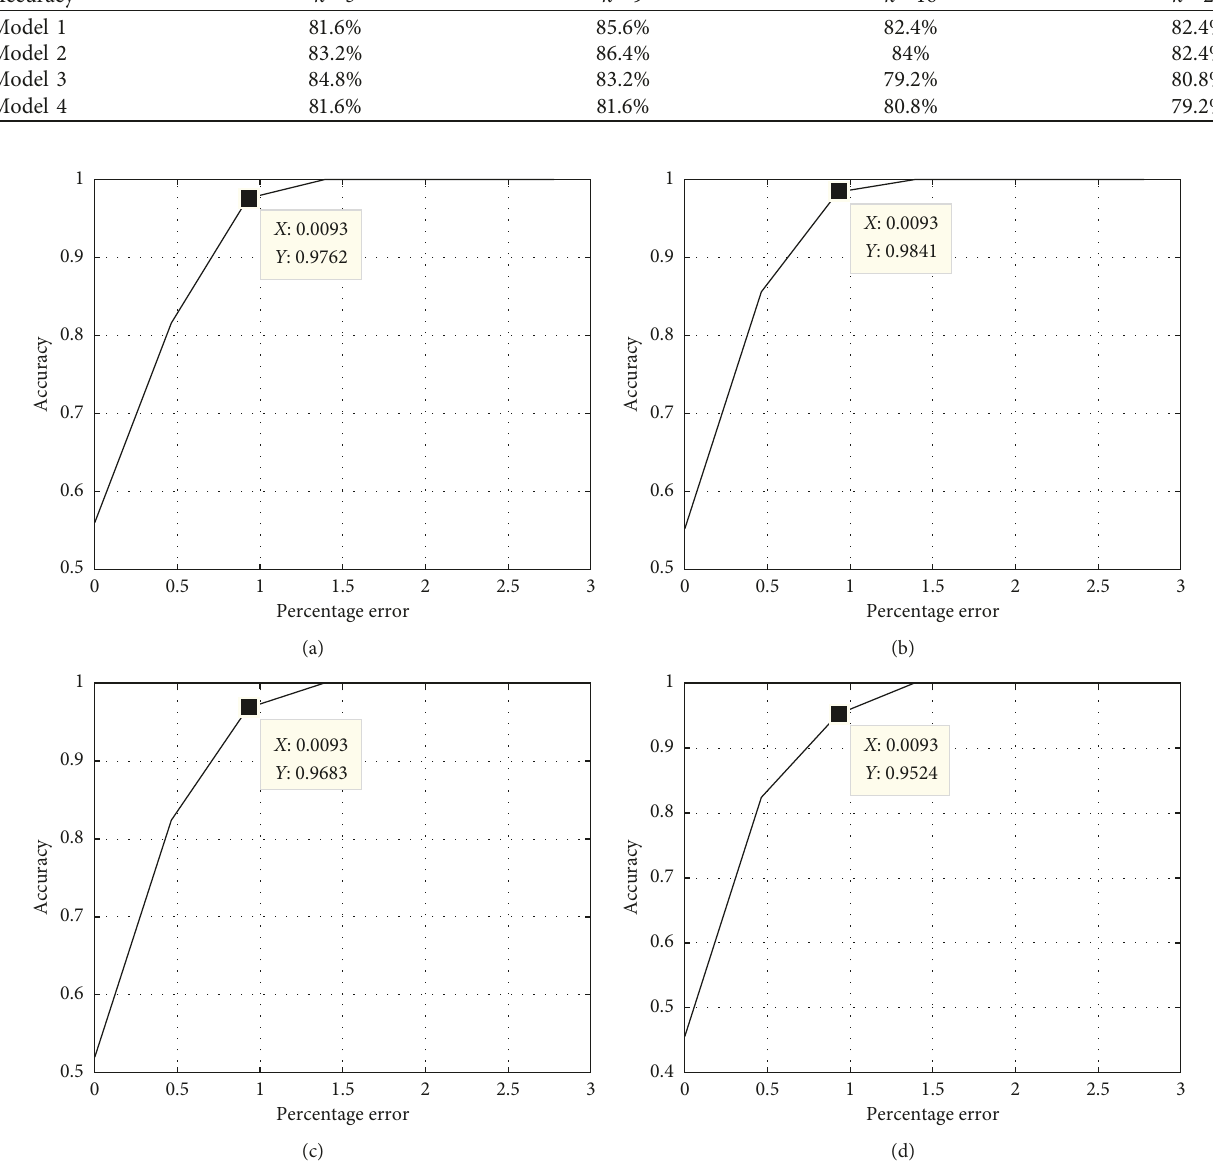
Figure 13: Recognition accuracy for different values of k. (a) k � 3. (b) k � 9. (c) k � 16. (d) k � 20.